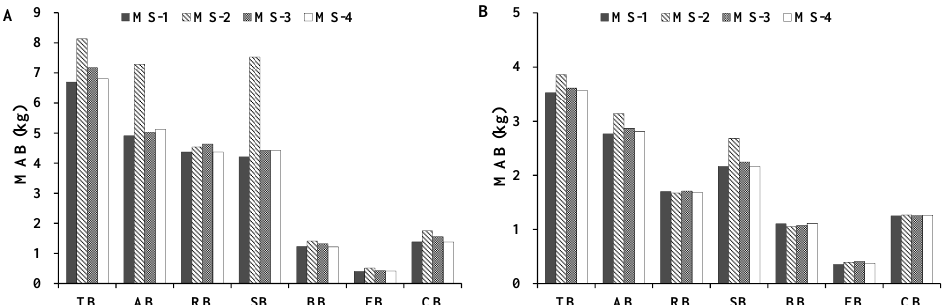
Figure 5. Mean absolute bias (MAB) of the four methods of estimating the individual biomass of ( A ) Dahurian larch and ( B ) white birch, where TB, AB, RB, SB, BB, FB, and CB stand for total, aboveground, root, stem, branch, foliage, and crown biomass, respectively.